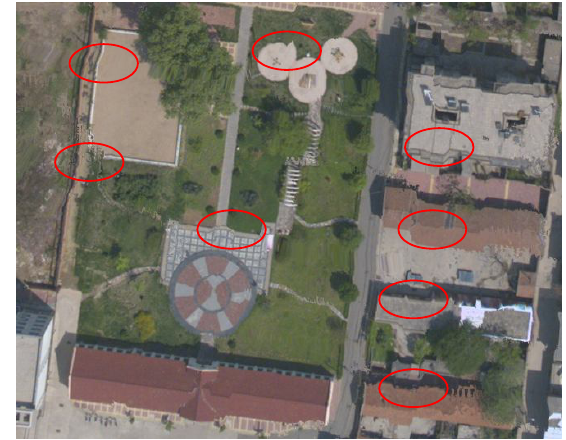
Figure 12. Local DOM before registration